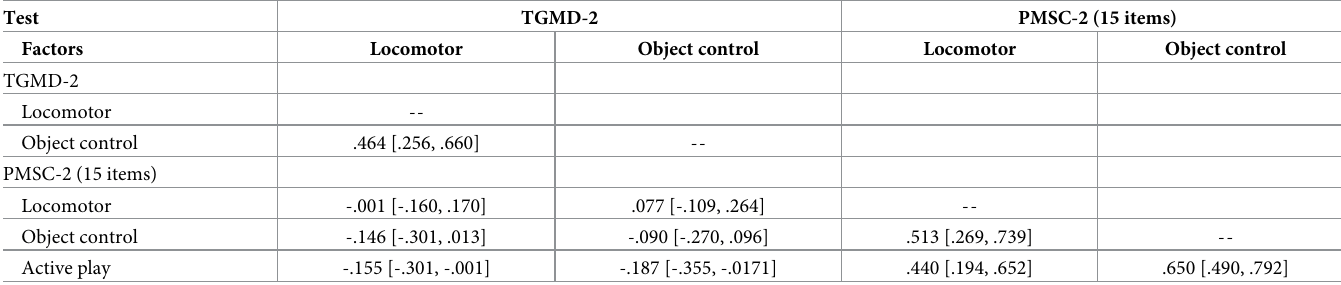
Table 3. Standardized estimates and 95% confidence intervals between latent factors ( n =